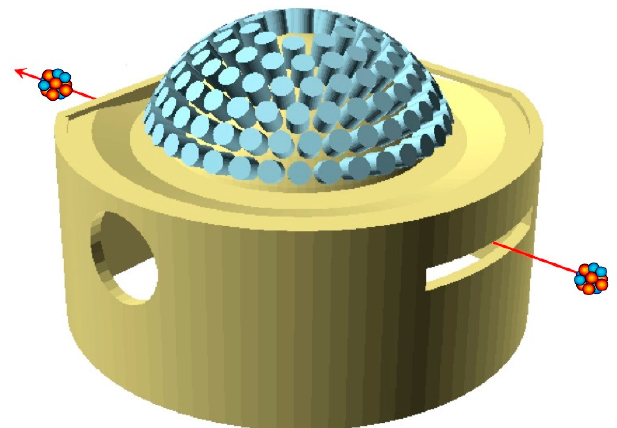
Figure 15. Sketch of the proposed configuration for the Gamma Detector Array (GDA). It consists of 139 LaBr 3 (Ce) cylindrical scintillators, 38 mm diameter and 50 mm length, readout by means of photomultiplier tubes and arranged in six concentric rings pointing at the target at 25 cm distance and covering ≈ 20% of the total solid angle.